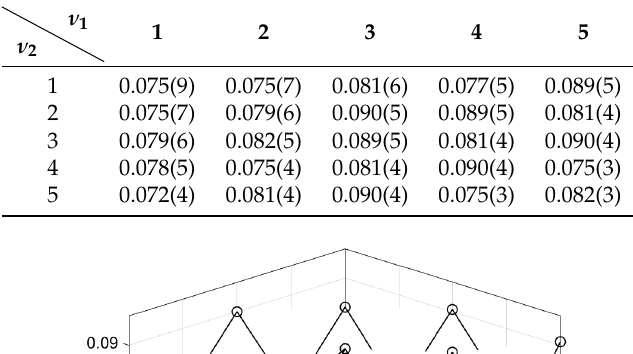
Table 2. Average CPU times and average numbers of V-cycles (given in parentheses) for various pre- and post-relaxation numbers after 100 time steps.